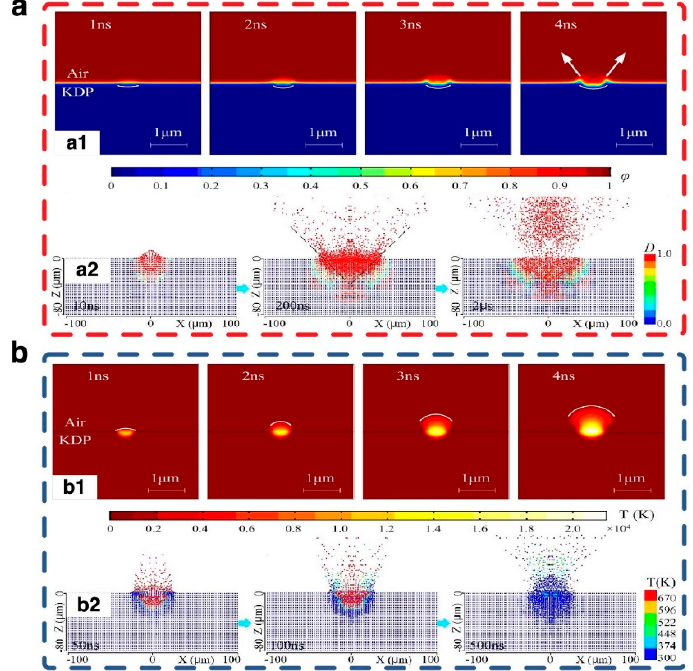
Figure 17. Evolution process of damage initiation. ( a ) Simulated damage crater formation process in the laser damage area; ( b ) Simulated temperature variation in the laser damage area [88,90].